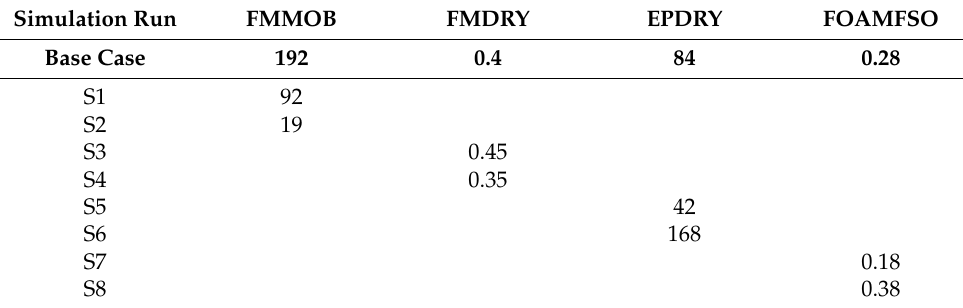
Table 4. Foam sensitivity parameters.